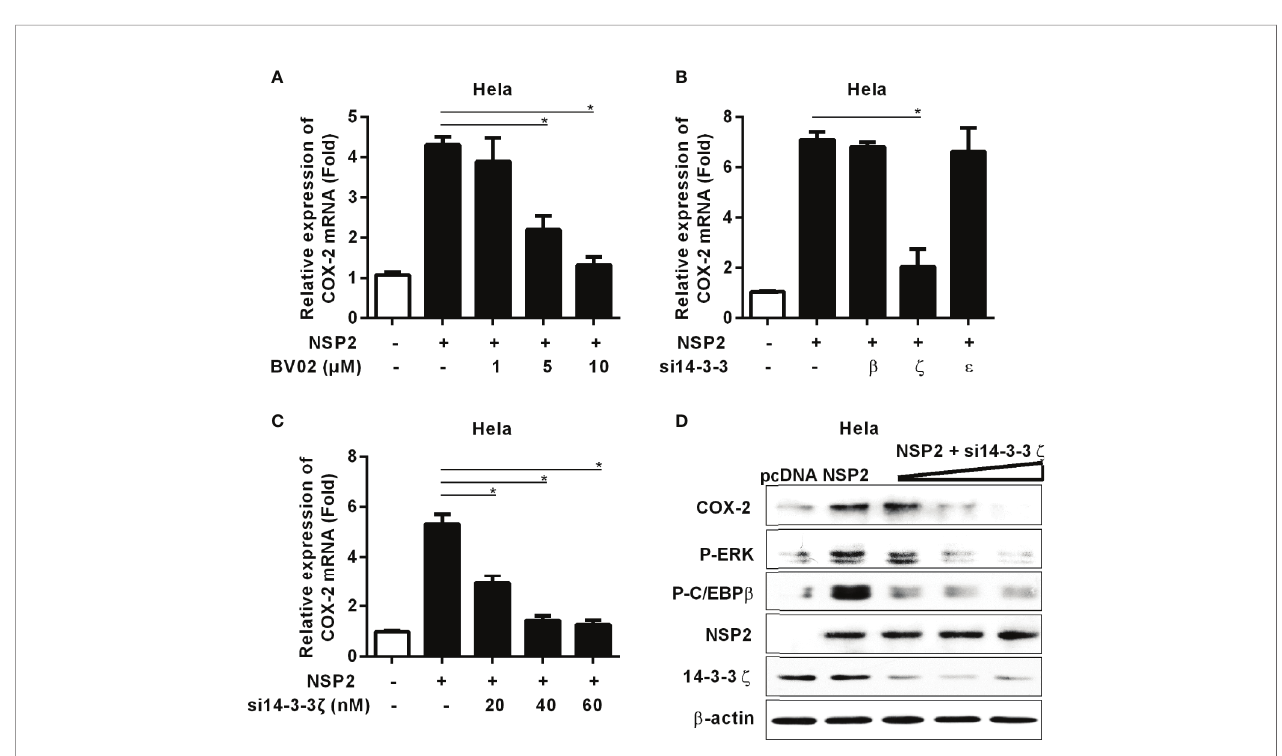
FIGURE 6 | 14-3-3 z participates in NSP-2-induced COX-2 production. (A) Hela cells were transfected with NSP2 (0.5 m g). At 6 hours post transfection, cells were treated with DMSO or the pan-inhibitor of 14-3-3 protein family (BV02) at the indicated concentrations. At 18 hours post-inoculation, cells were collected and subjected to the real-time PCR to measure COX-2 mRNA level. (B) Hela cells were co-transfected with NSP2 and siRNA targeting 14-3-3 b , 14-3-3 ϵ , and 14-3-3 z , respectively. At 24 hours later, cells were harvested for COX-2 mRNA analysis by real-time PCR. (C, D) Hela cells were co-transfected with NSP2 and siRNA targeting 14-3-3 z at the indicated doses, respectively. Cells were harvested for COX-2 mRNA analysis by real-time PCR (C) and COX-2, p-ERK, p-C/EBP b , 14-3- 3 z , and NSP2 protein analysis by Western-blot (D) . Data are representative of three independent experiments (mean ± SEM). Statistical analysis was performed by Student ’ s t -test. *, P < 0.05